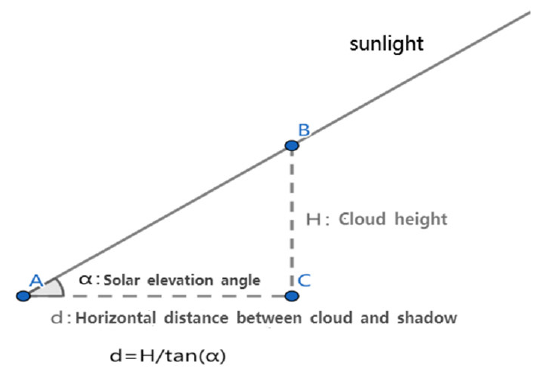
Figure 8. Demonstration of shadow length.